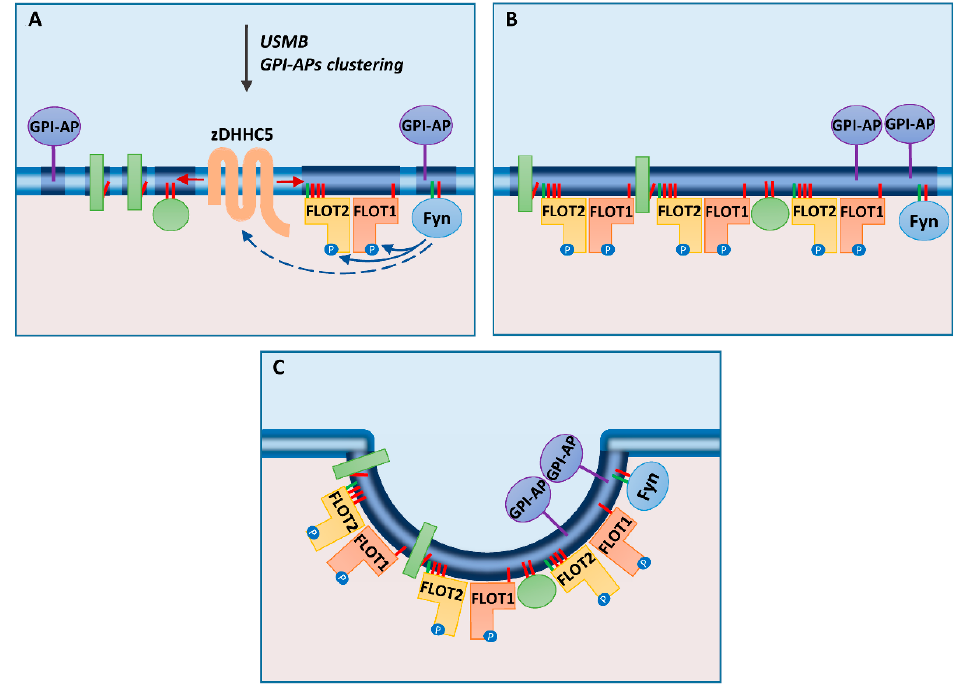
Figure 2. Flotillin-mediated endocytosis: ( A ) After stimulation of cells with ultrasound, microbubbles, and desipramine (USMB) or clustering of glycosylphosphatidylinositol (GPI)-anchored proteins (GPI-APs), zDHHC5 is activated indirectly by Fyn kinase, which also phosphorylates flotillins. ( B ) S -palmitoylation of flotillins and other cell-surface proteins induces coalescence of ordered regions (rafts) of the plasma membrane. ( C ) Flotillins can drive invagination of the membrane preceding pinching off of a vesicle. N -myristoylation and S -palmitoylation are marked by green and red bars, respectively. Transmembrane and peripheral membrane proteins are indicated by green rectangles and spheres, respectively.